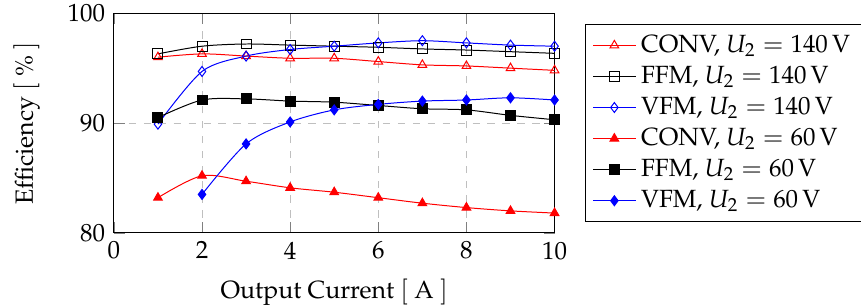
Figure 10. Total loss of three converters ( U 1 = 80 V, r ON = 40 m Ω ).